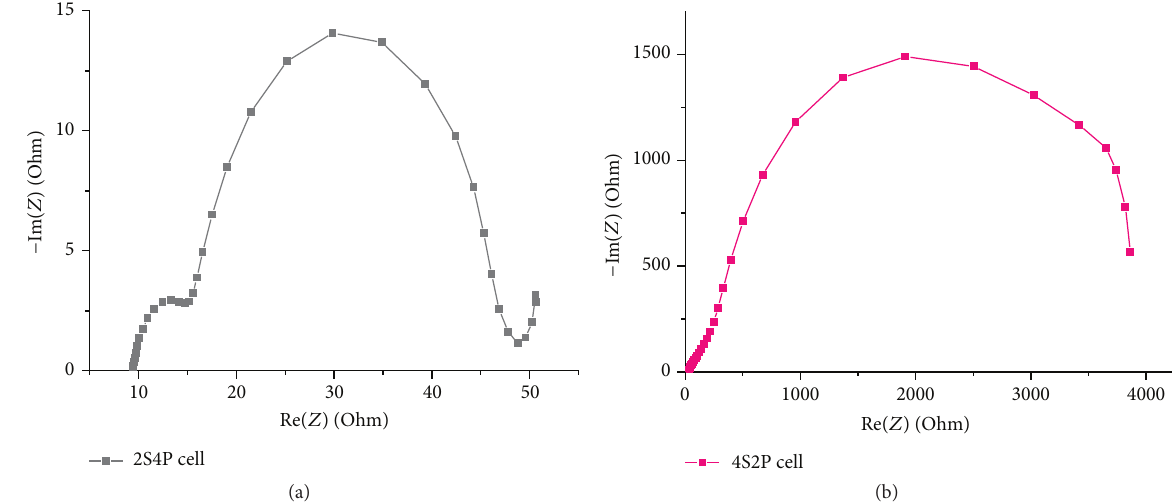
Figure 7: Nyquist plots based on different DSSC model assemblies (a) series-parallel module: 2S4P; (b) series-parallel module: